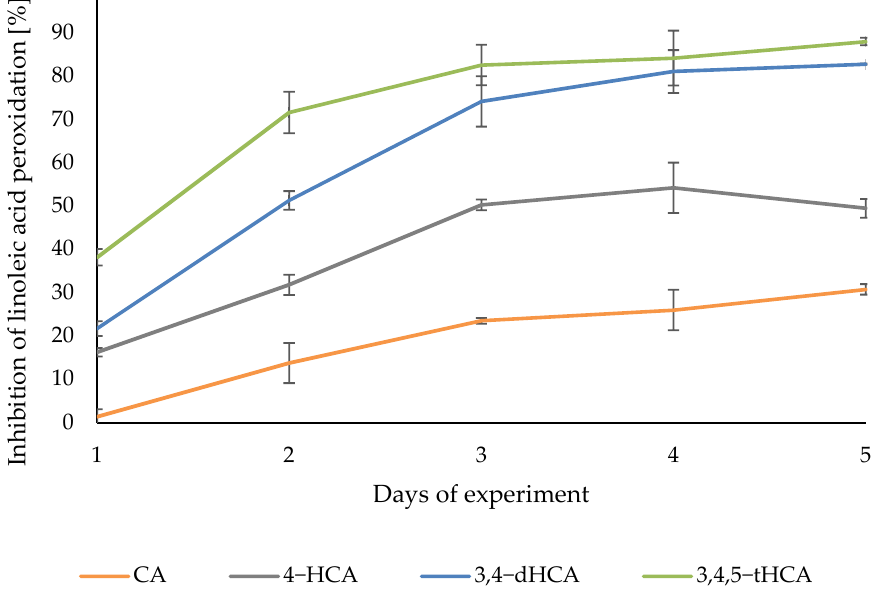
Figure 11. The degree of linoleic acid peroxidation inhibition by CA; 4−HCA; 3,4−dHCA; and 3,4,5−tHCA.